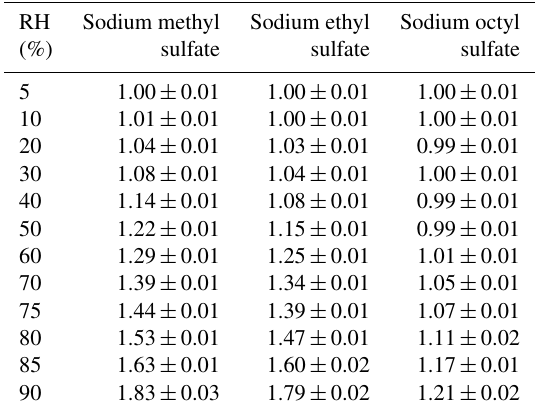
Figure 5. Hygroscopic growth factors of (a) methyl- and octyl-OS and (b) ethyl-OS aerosols as a function of RH. Solid curves repre- sent fitted curves in our work using Eq. (1). For comparison, the fit- ted curves reported by Estillore et al. (2016) are presented by dashed curves. Table 2. Hygroscopic growth factors (GFs) of methyl-, ethyl- and octyl-OS aerosols at different RHs. All the errors given in this work are standard deviations.